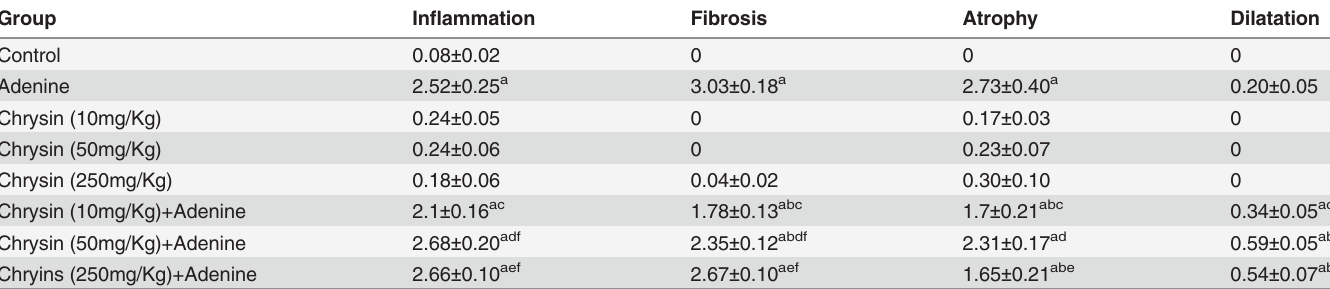
Table 3. Effect pf chrysin on kidney morphology in rats with adenine-induced kidney chronic